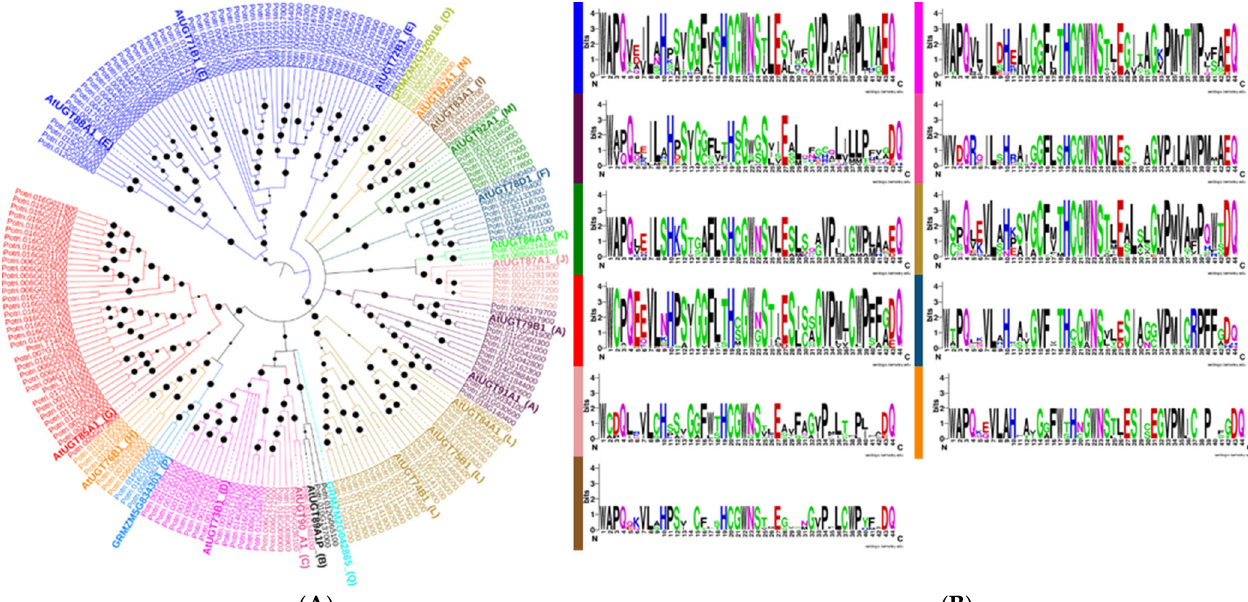
Figure 1. Phylogenetic analysis of 191 Populus UDP glycosyltransferases (UGTs) and their PSPG motifs in each phylogenetic group (A and B). ( A ) Sixteen major phylogenetic groups (A–P) were found in Populus . The evolutionary history was inferred using the Neighbor-joining method. The optimal tree with the sum of branch lengths = 14,369.13429772 is shown. The tree is drawn to scale, with branch lengths in the same units as those of the evolutionary distances used to infer the phylogenetic tree. The evolutionary distances were computed using the number of differences method and are in the units of the number of amino acid differences per sequence. The analysis involved 213 amino acid sequences. All ambiguous positions were removed for each sequence pair. There were a total of 503 positions in the final dataset. Evolutionary analyses were conducted in MEGA7. Bootstrap values are shown in black dots at each node. ( B ) Web logos of PSPG motifs from different phylogenetic groups are shown in different colors.